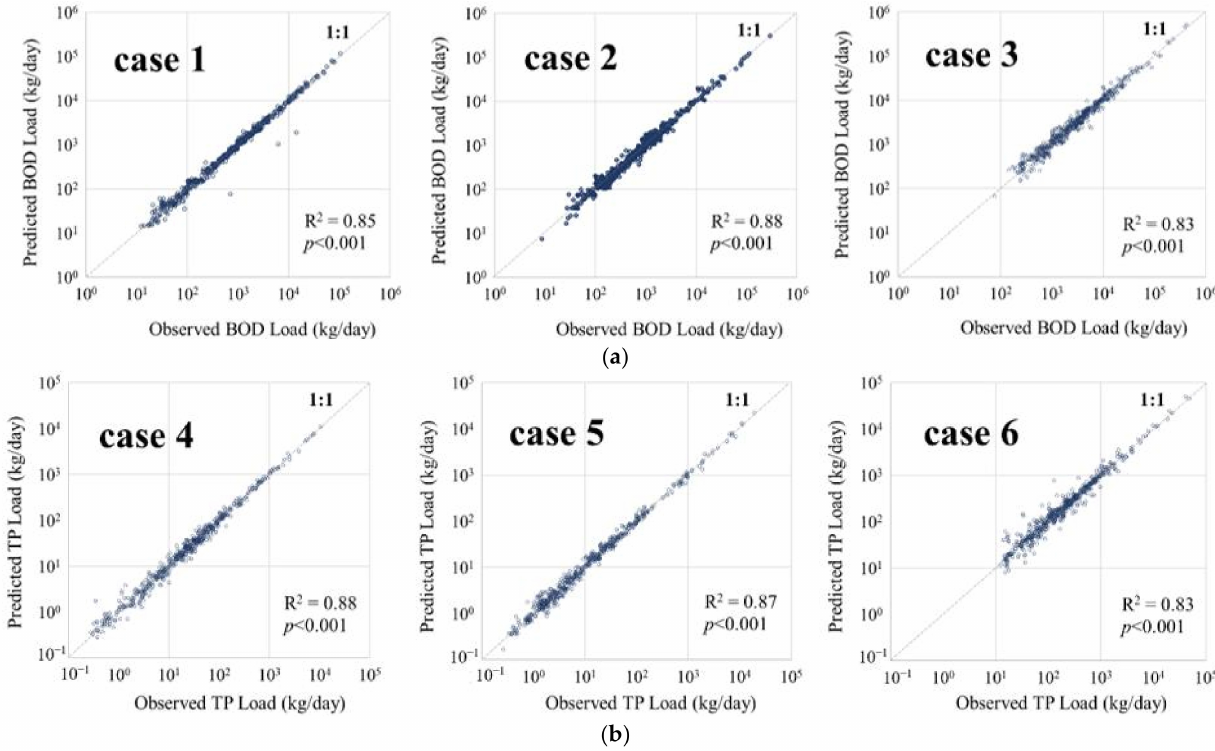
Figure 10. Scatter plot between the predicted values of the CNN model and observed values: ( a ) BOD load; ( b ) TP load. In this study, r , NSE, RMSE, and MAPE were used to evaluate the performance of the CNN model, whose results are listed in Table 5. For the evaluation of the model using r , the model was weak when the value of r ranged 0.1–0.3, moderate from 0.4–0.6, strong from 0.7–0.9, and perfect when the value was 1 [53]. For the NSE, the model was moderate at NSE values from 0.6–0.8 and good at values above 0.8 [54]. In all cases, r showed a strong correlation of 0.9, and all cases were evaluated as strong, while all NSE values were 0.9, such that all cases were good. In the evaluation using the RMSE, in cases 1–3 for the BOD load simulation, the values were 1031.1, 1152.2, and 5376.5 kg · day − 1 , respectively, and the RMSE value was the largest for case 3, which represented the BH watershed. In cases 4–6 for the TP load simulation, the values were 53.6, 169.5, and 476.5 kg · day − 1 , respectively, and the RMSE value was the largest for case 6, which represented the BH watershed. In the evaluation using MAPE, the values were 11.5, 15.9, and 20.1% for cases 1–3, and 17.9, 16.3, and 21.3% for cases 4–6, respectively, and similar to the case for the RMSE, the value of MAPE was the highest for the BH